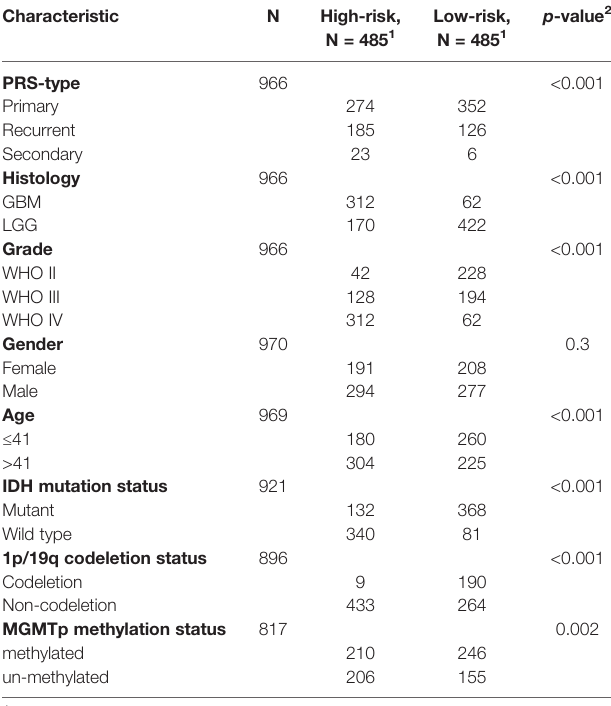
1 Statistics presented: n. 2 Statistical tests performed: chi-square test of independence.